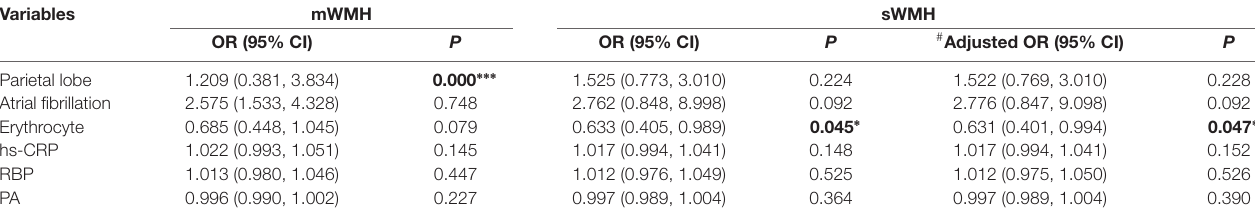
TABLE 4 | Multivariate prediction of different cognitive levels with ordinal logistic regression.